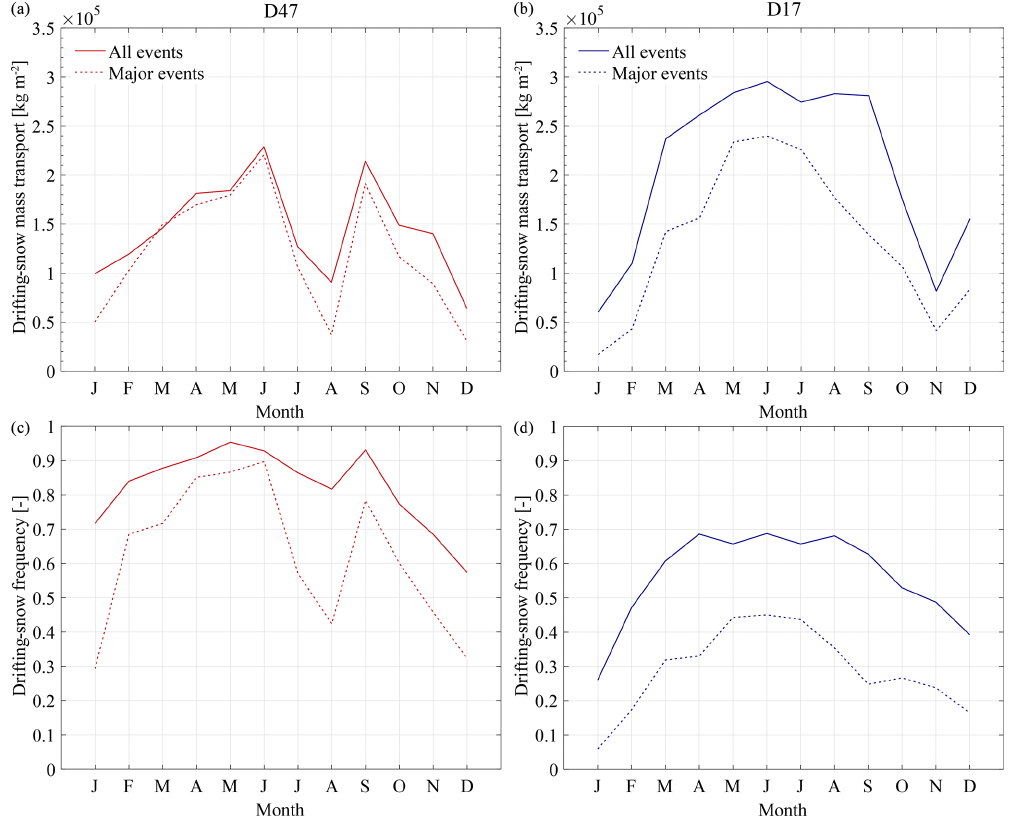
Figure 7. Intra-annual variability in drifting-snow mass transport (a, b) and related drifting-snow frequency (c, d) at D47 (a, c) and D17 (b, d) . The relative contribution of major drifting-snow events (see text) is highlighted in dotted lines. Summed mass transport and frequency values were first determined for each month and averaged within each monthly bin to produce monthly average values. The variability (standard deviation) is not shown due to the short length of the time